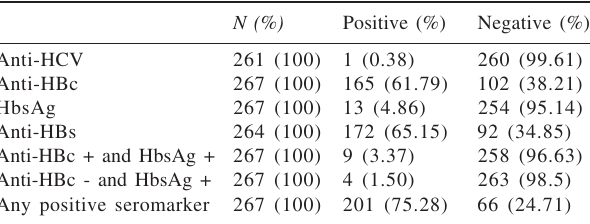
Table 1 - Summary of Hepatitis B virus (HBV) and Hepatitis C virus (HCV) serologic results.